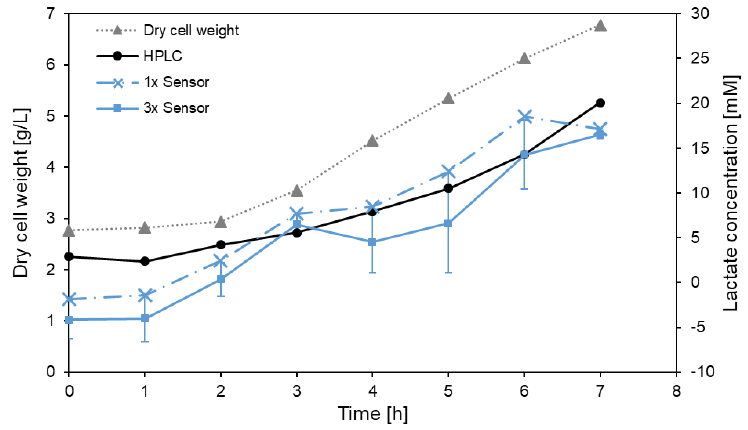
Figure 5. Monitoring of lactate off-line for seven hours of C. glutamicum cultivation in CGXII medium using the single-use biosensor, and its comparison with off-line HPLC lactate measurements. The 1x graph shows the first recordings with individual biosensors. The 3x graph shows the mean value of recordings of three individual thrice-used biosensors. The cultivation chart also shows the growth of the bacteria as dry cell weight concentrations.